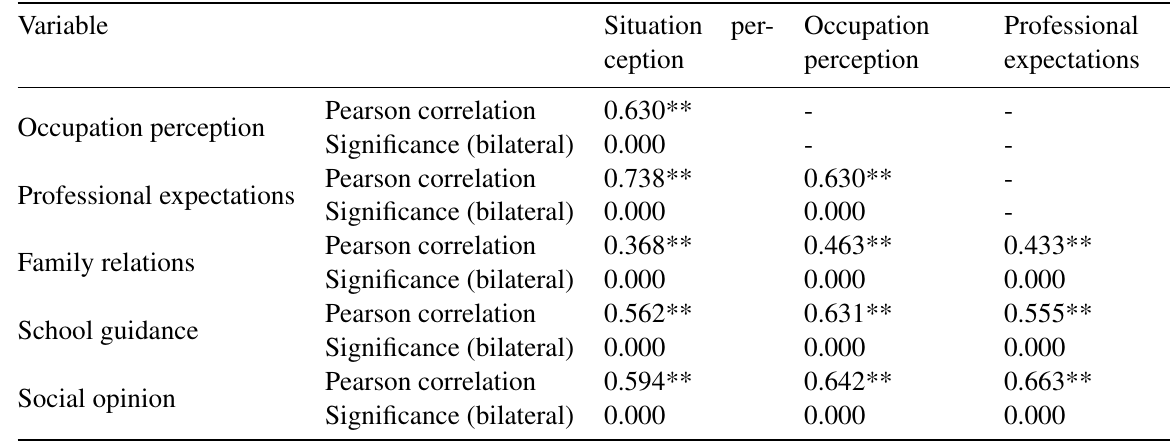
Table 10 Multivariate correlation analysis (N289).